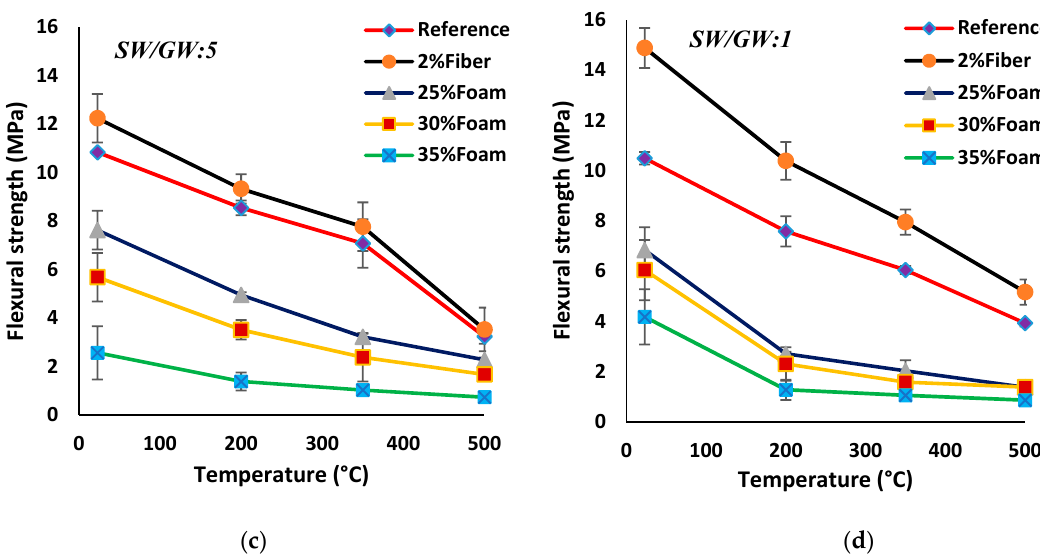
Figure 16. Impact of high temperatures (200, 350, 500 ◦ C) on the compressive strength of mix compositions: ( a ) SW50 / GW10; ( b ) SW30 / GW30; and on the flexural strength of mix compositions: ( c ) SW50 / GW10; ( d ) SW30 / GW30.